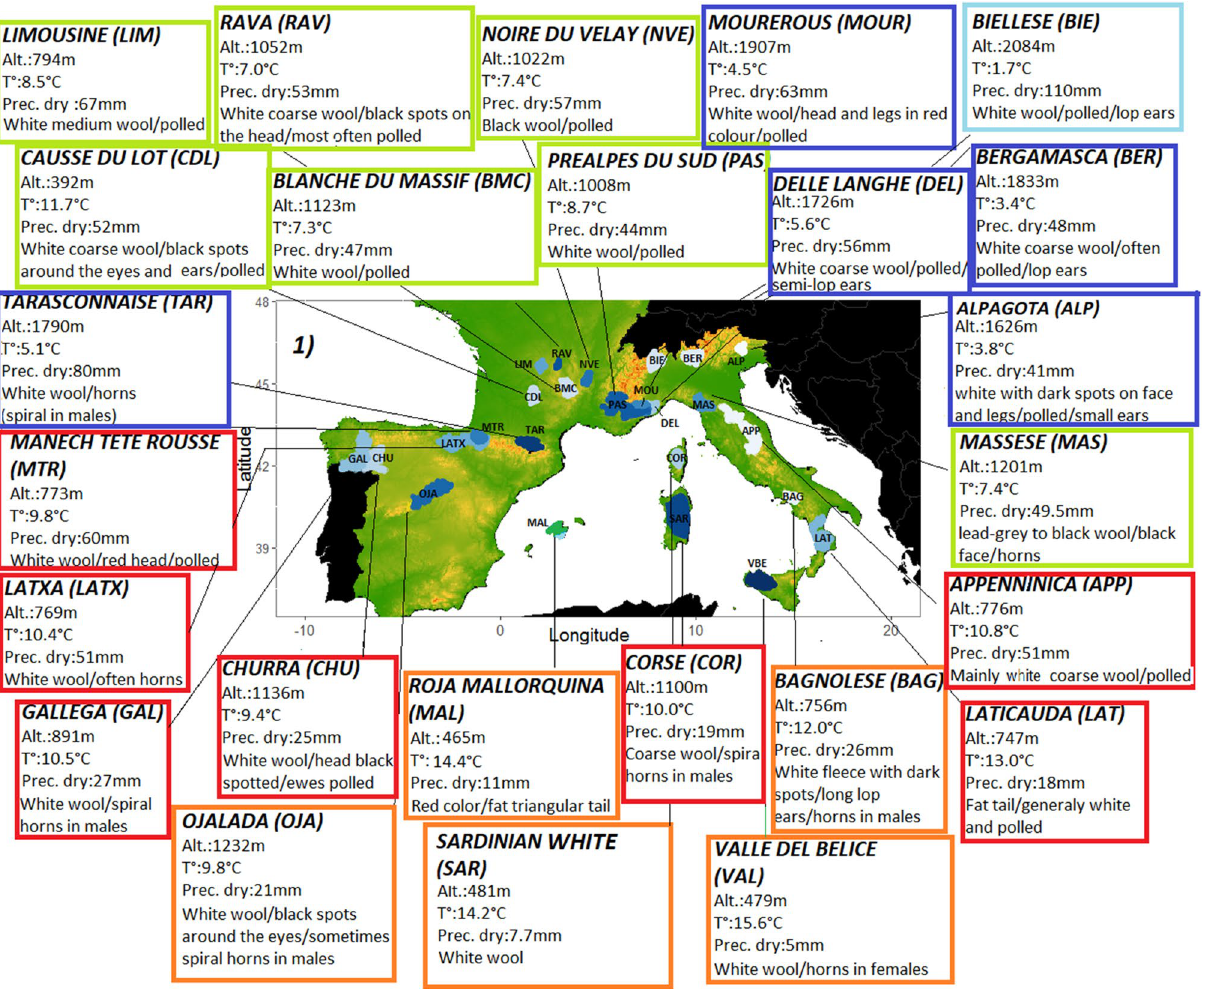
Figure 2. Description of sheep cradles as a function of environmental variables: synthetic descriptions of cradles and some characteristic breed phenotypic traits. The breed labels are color coded according to the clustering ranking defined by the PCA/HCPC analysis shown in Fig.